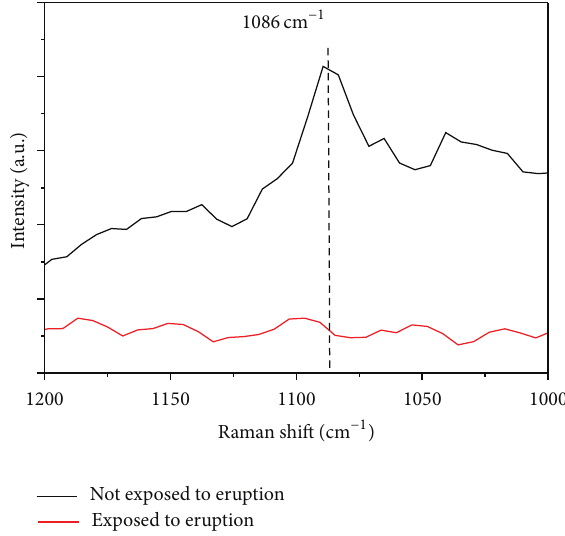
Figure 6: Raman spectra taken on mural samples from casa del marinaio (Pompeii), exposed and not exposed to Vesuvius’s eruption. The band position relative to the strongest Raman band from the calcium carbonate is